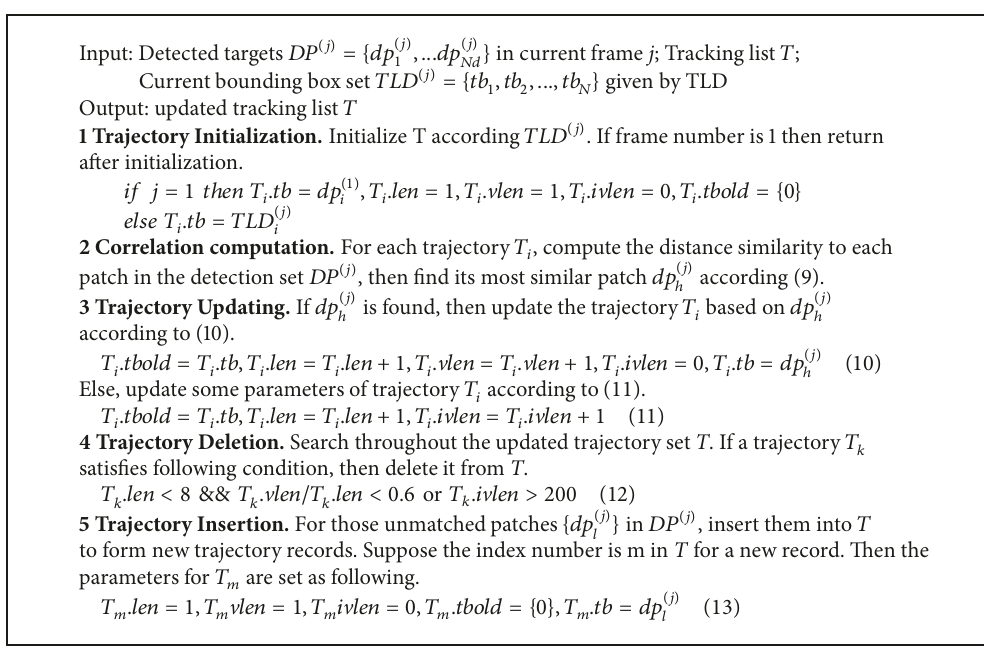
Algorithm 1: The flow for multiobject tracking.